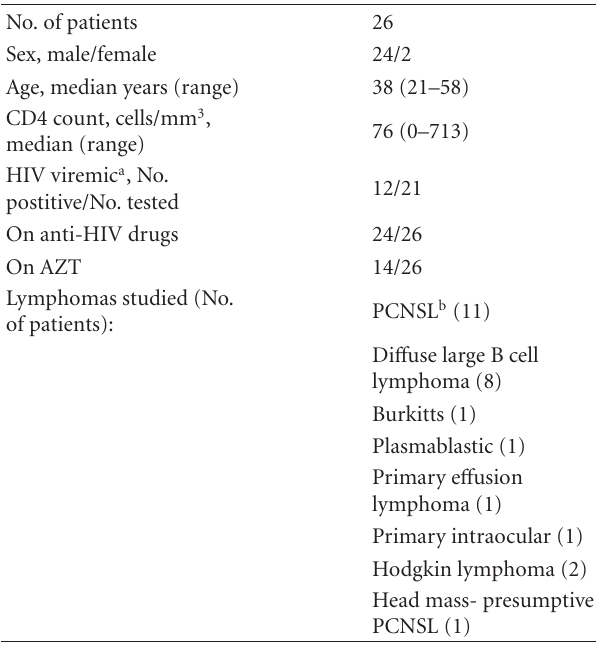
Table 1: HIV-1 Lymphoma Patient Cohort Characteristics.